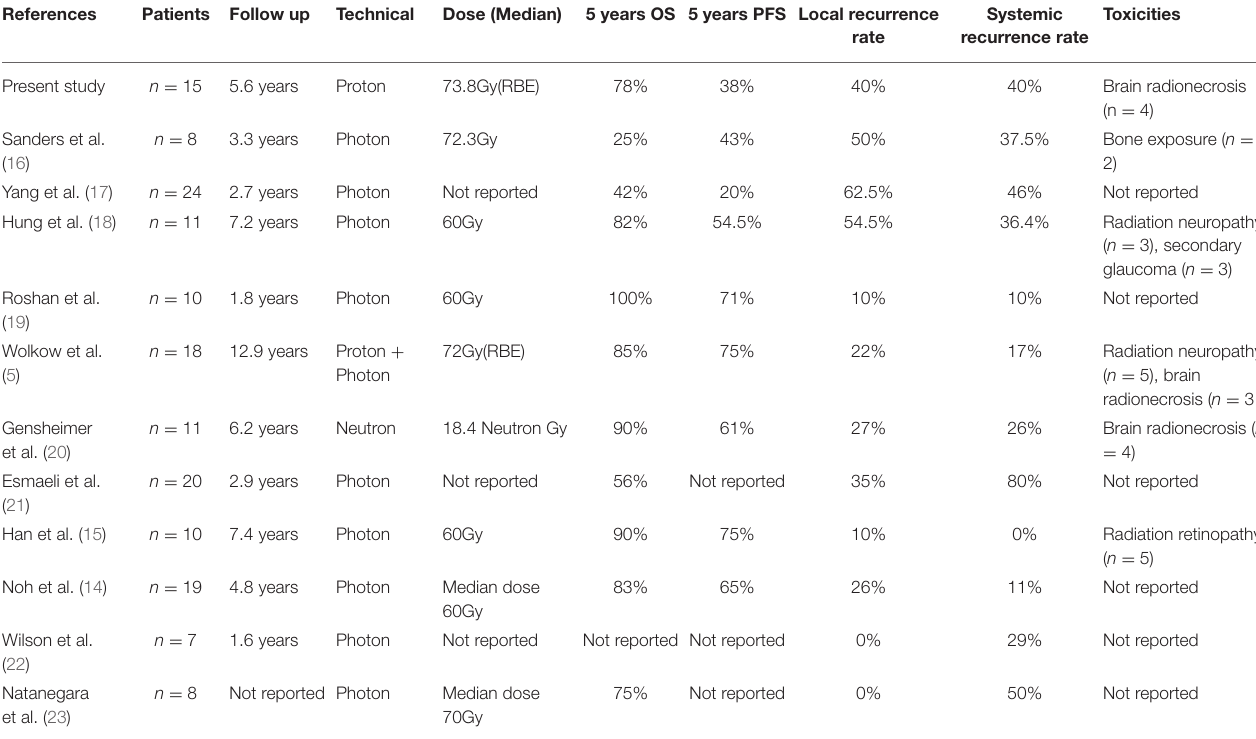
TABLE 5 | Systematic review of studies dealing with irradiation for lacrymal gland adenoid cystic